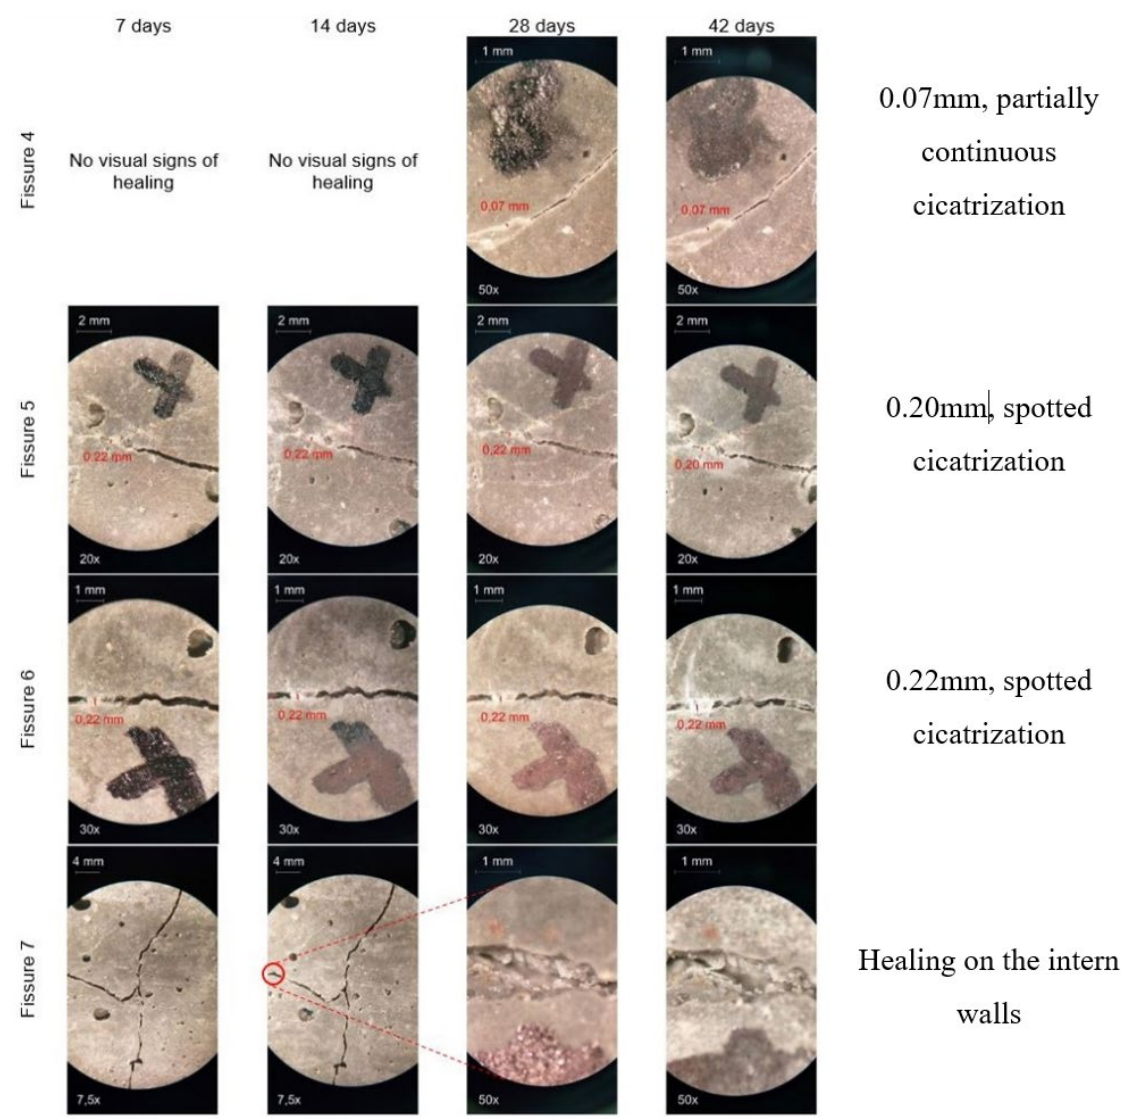
Figure 9 – Self-healing activity of sample BAC.7 at several ages